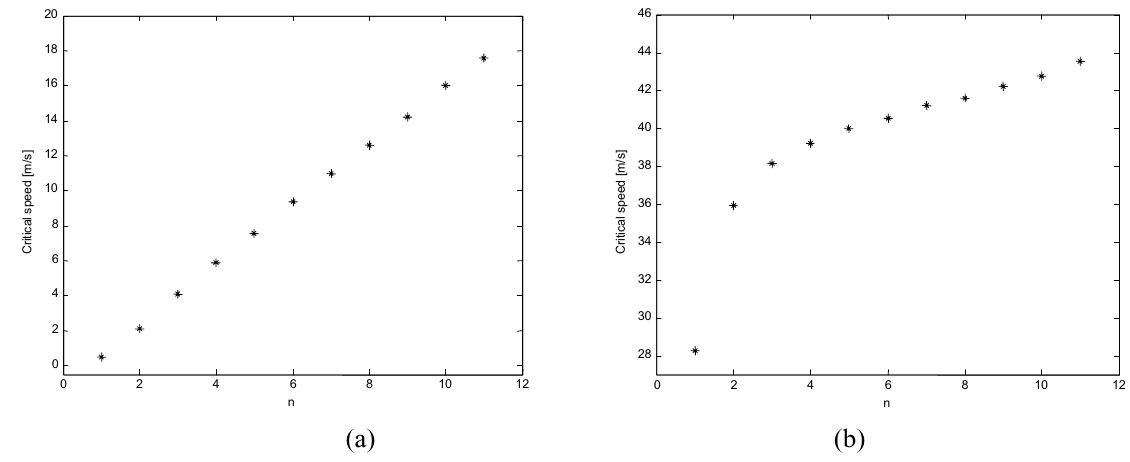
Fig. 12. Critical speed with P int = 0 (a) and P int = 100 bar.